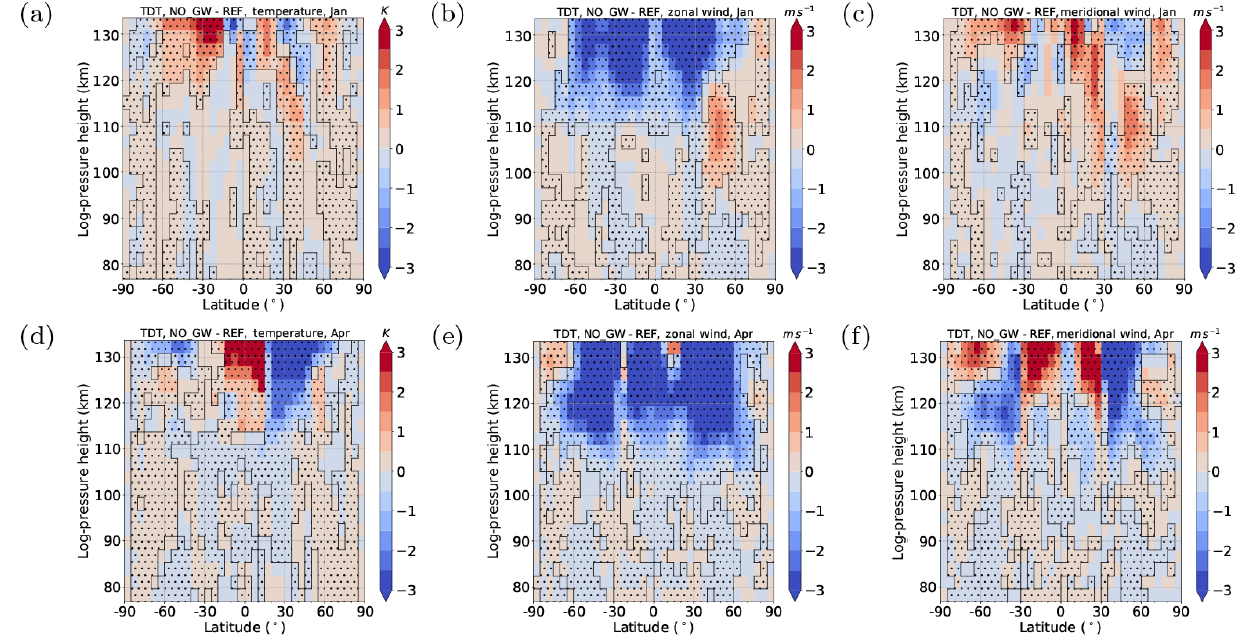
Figure 12. As in Fig. 10 but for NO_GW simulation.